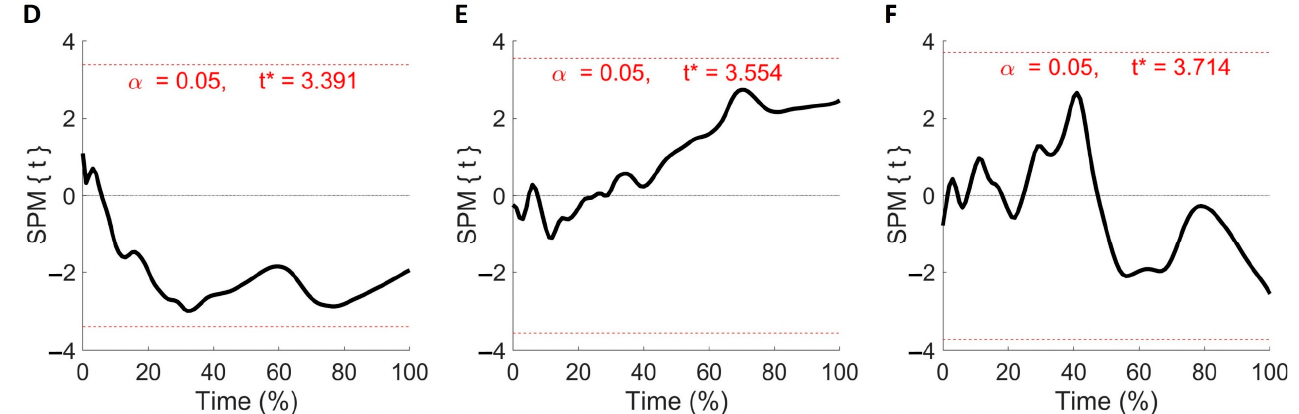
Figure 3. Sagittal plane joint moment. Descriptive statistics for each condition (mean ± 1 standard deviation error cloud) for the ankle ( A ), knee ( B ), and hip ( C ) joint moments. Time was determined from initial contact (0%) to peak knee flexion (100%). The black line is the t-value of each time point for the ankle ( D ), knee ( E ), and hip ( F ) joint moment. The dotted redline is the threshold of significance. No significant difference was observed in the sagittal plane joint moment between the landing conditions.